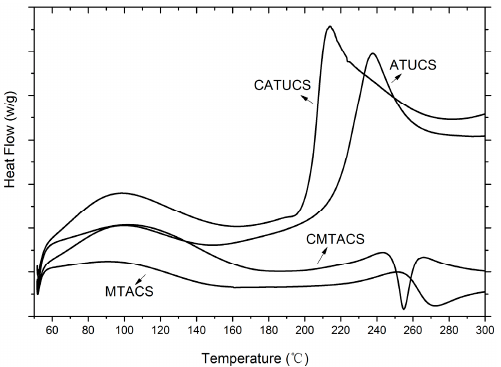
Figure 5. DSC curves of acetyl thiourea chitosan (ATUCS), 3-methyl-1,2,4-triazolyl chitosan (MTACS), chloracetyl thiourea chitosan (CATUCS), and 3-chloromethyl-1,2,4-triazolyl chitosan (CMTACS) derivative.